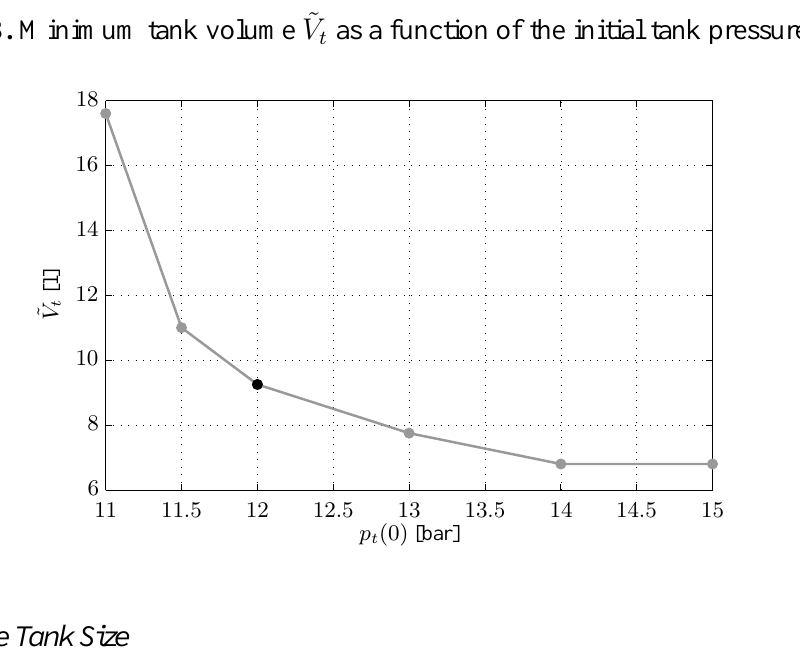
Figure 8. Minimum tank volume ˜ V